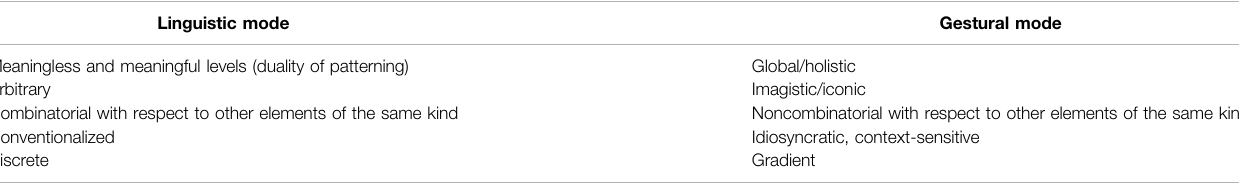
TABLE 1 | Dichotomy between the linguistic and the gestural, after McNeil